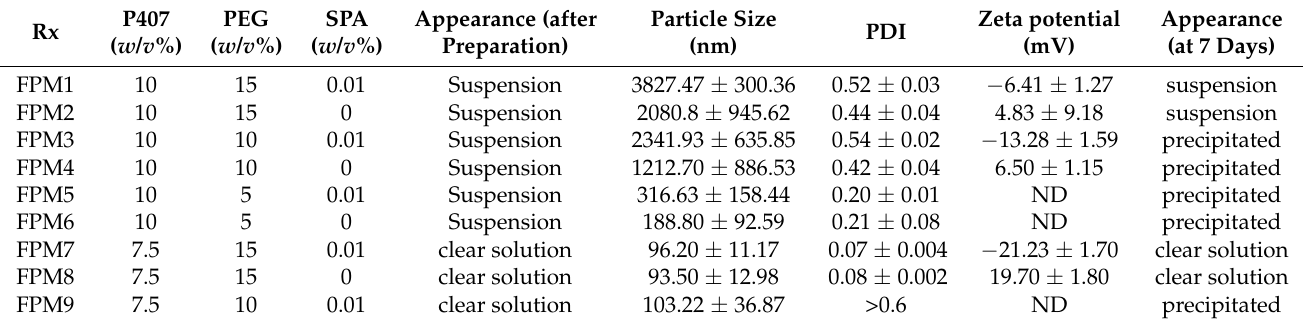
Table 1. 18 different formulations and characterizations were generated by varying the concentra- tions of P407 (% w / v ), PEG (% w / v ), and SPA (% w / v ) in polymeric micelles containing fluocinolone acetonide (0.1% w / v )